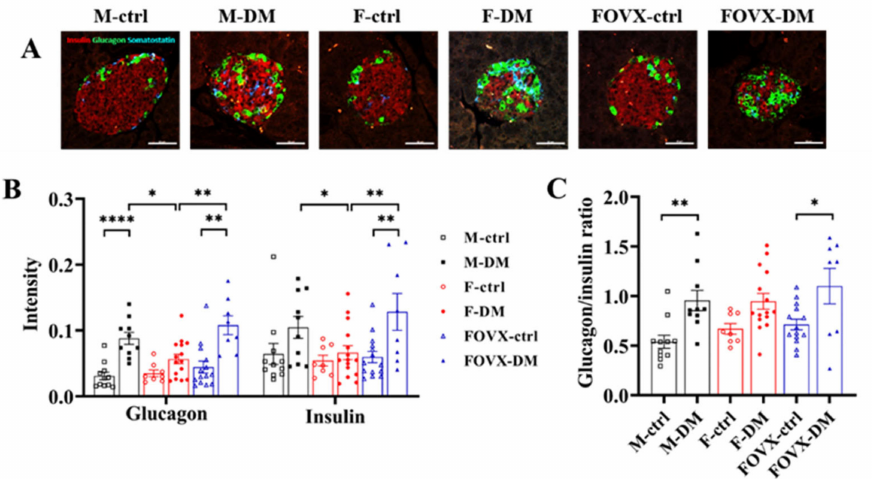
Figure 4. Differences in cell composition between the diabetic and control groups at week 6 after STZ treatment. ( A ) Immunofluorescence staining of pancreatic islets was performed with anti-glucagon and anti-insulin. The intensities of α -cells (glucagon, green) and β -cells (insulin, red) ( B ) and the glucagon/insulin ratio ( C ) were measured. The α -cells of M-DM and FOVX-DM were significantly increased compared with each control group. Data were analyzed using an independent two-sample t -test. * p < 0.05, ** p < 0.01, **** p < 0.0001 compared with the respective control group.